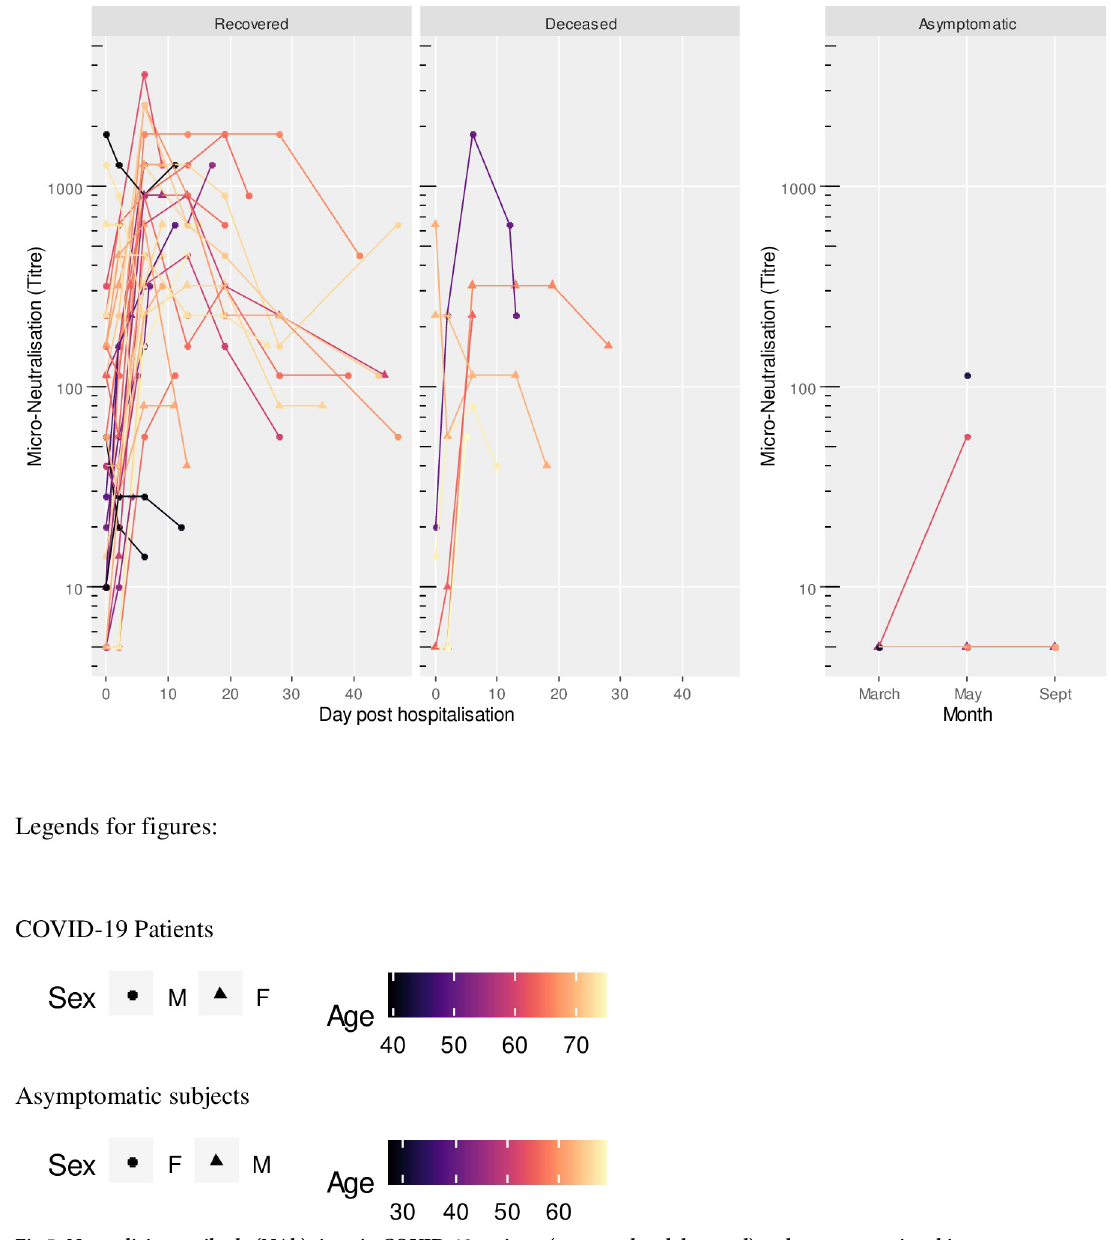
Fig 5. Neutralizing antibody (NAb) titres in COVID-19 patients (recovered and deceased) and asymptomatic subjects. same time, 19 out of the 21 subjects had a second blood draw in May, and 14 of them a third blood draw in September. Four (4) subjects had the rhino-pharyngeal swab positive in May and a blood draw at the same time, of whom 1 subject had a second blood draw in Septem- ber. Asymptomatic subjects did not receive any medication during the study period that may have interfered with antibody response. Out of 25 asymptomatic subjects, 16 (64.0%) were negative to any antibody at any time point. Nine (9) subjects (36.0%) had at least one detectable antibody type at least at one time point. At the first time point, 6 subjects (24.0%)